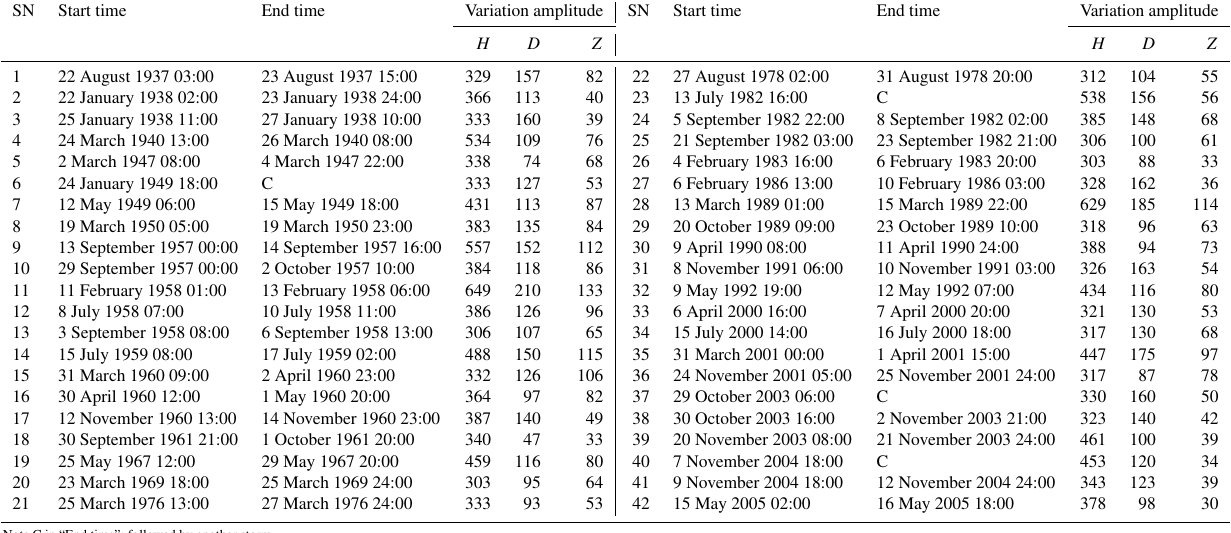
Table 3. List of geomagnetic storms that have occurred at the SSH since 1933.